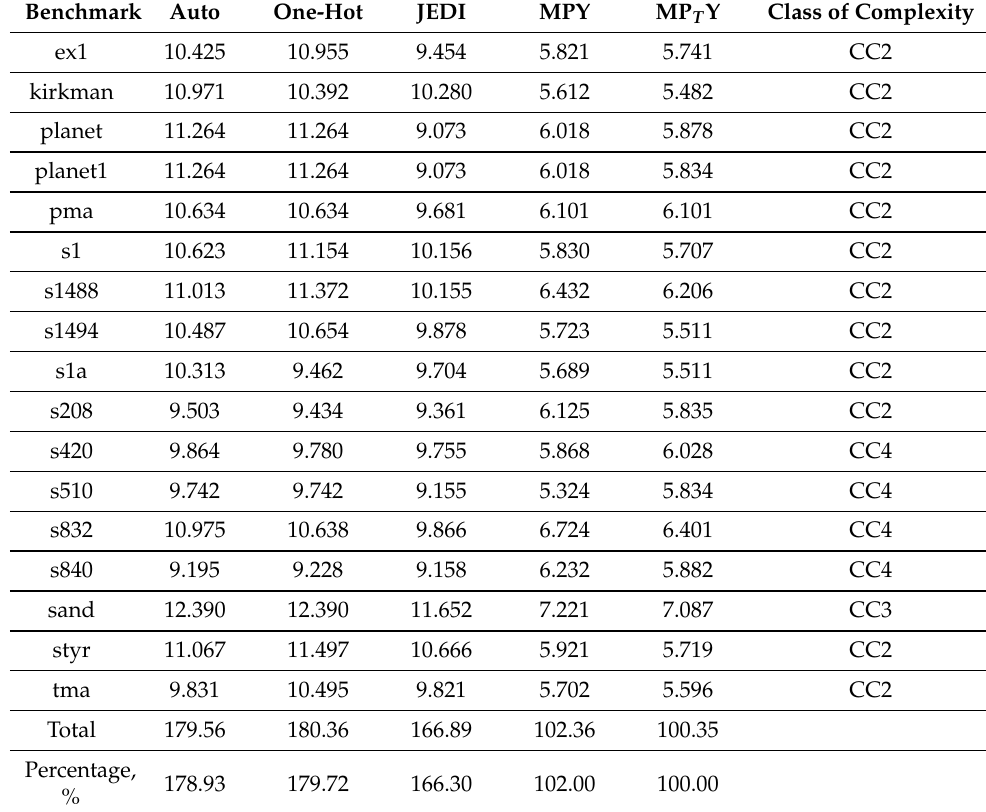
Table 13. Cycle times for classes CC2-CC4 (nanoseconds).